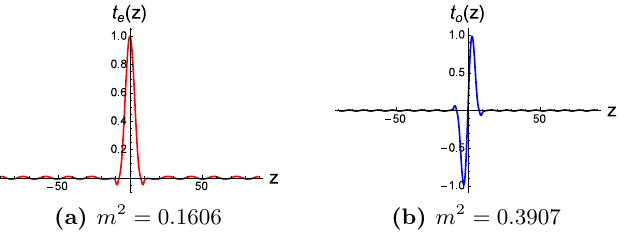
Figure 6. Plots of the (cid:12)rst even and (cid:12)rst odd parity resonance modes quasi-localized on the double brane described by (3.5). The parameters are set to k = 1, b = 1 : 8 and m 2 = 0 : 1606 for t e ( z ), m 2 = 0 : 3907 for t o ( z